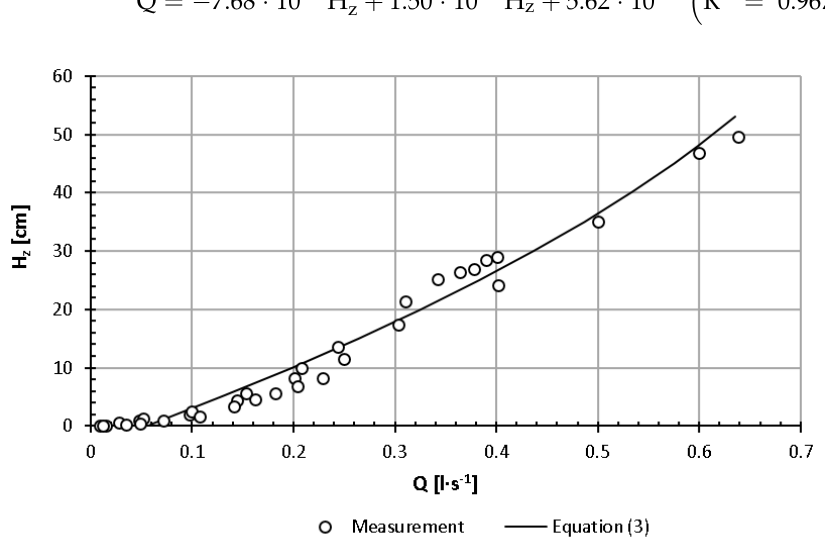
Figure 8. Reduced flow curve Q of the tested hole regulator openings.